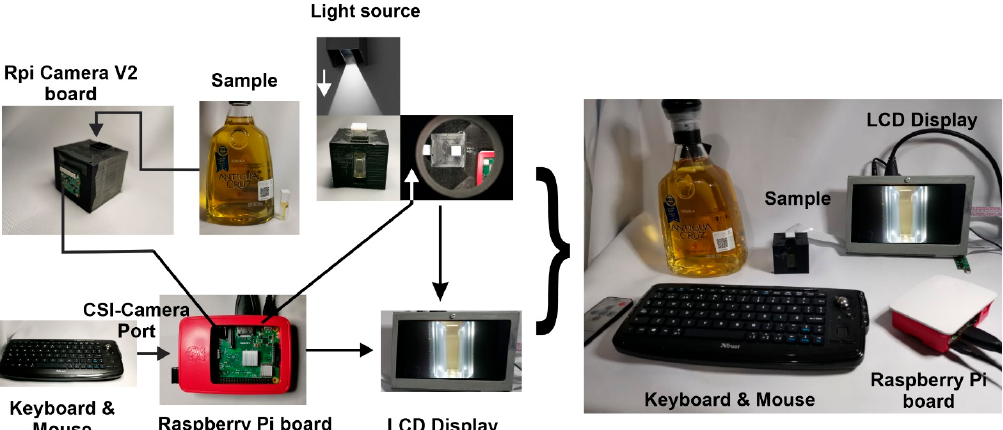
Figure 1. Schematic diagram of the developed Electronic Eye showing different electronic parts assembled and communication interface used.